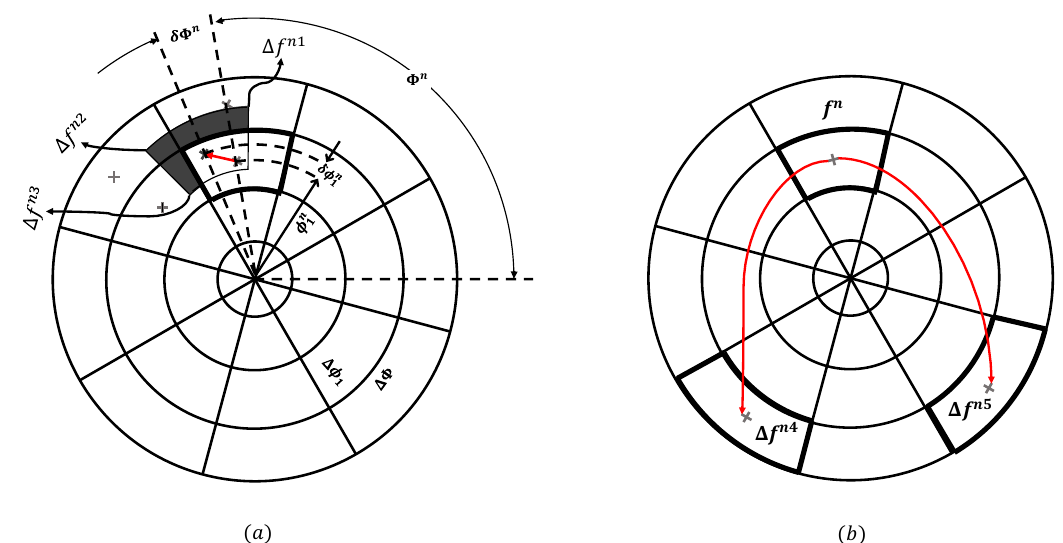
Figure 7. A schematic representing volume fraction transfer scheme from cell n: ( a ) to neighboring cells due to reorientation by slip and ( b ) to neighboring cells due to reorientation by